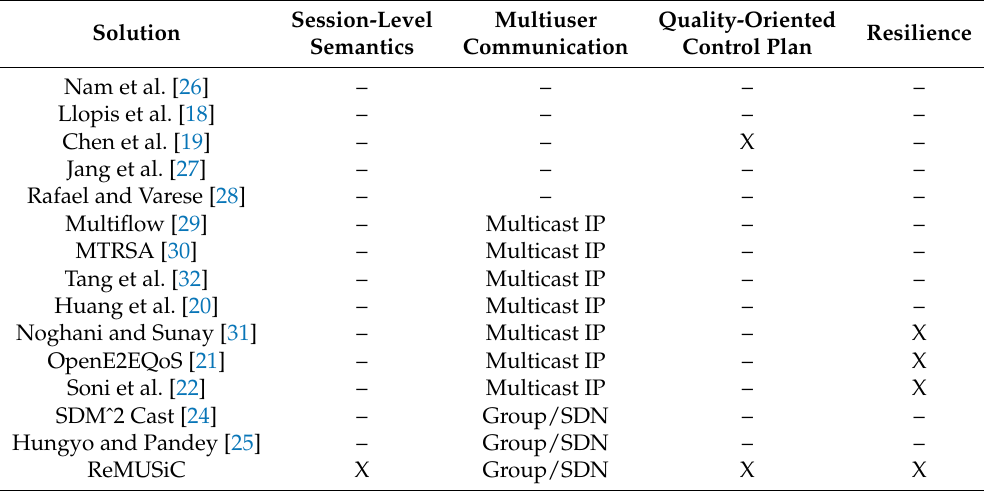
Table 1. Analysis of existing